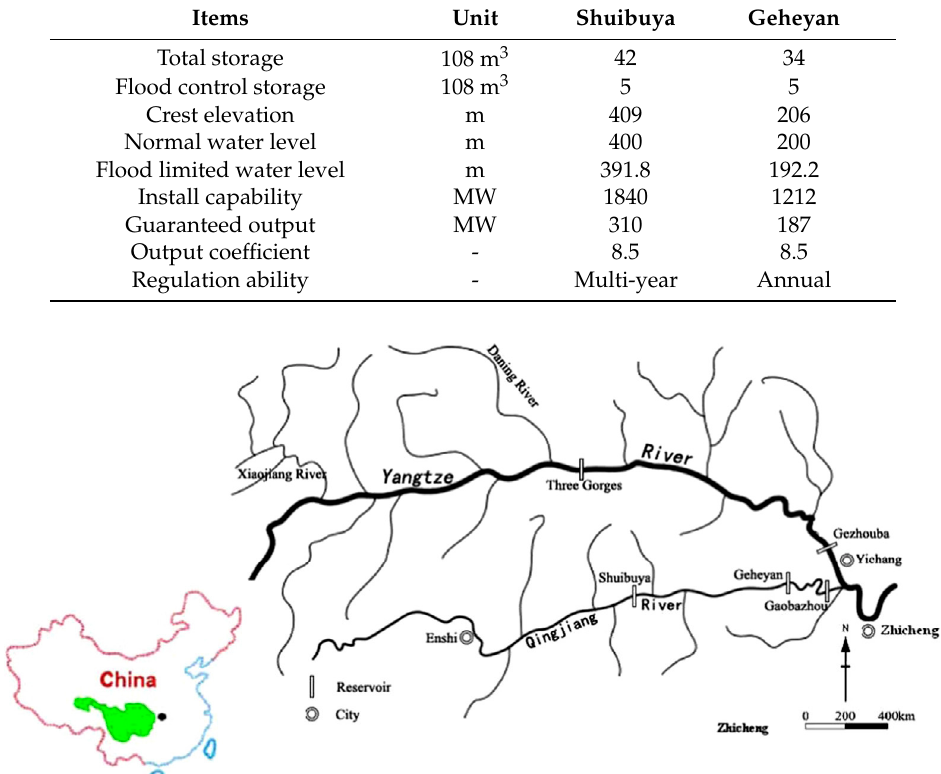
Table 1. Parameters of the Shuibuya and Geheyan hydropower stations in Qingjiang River.